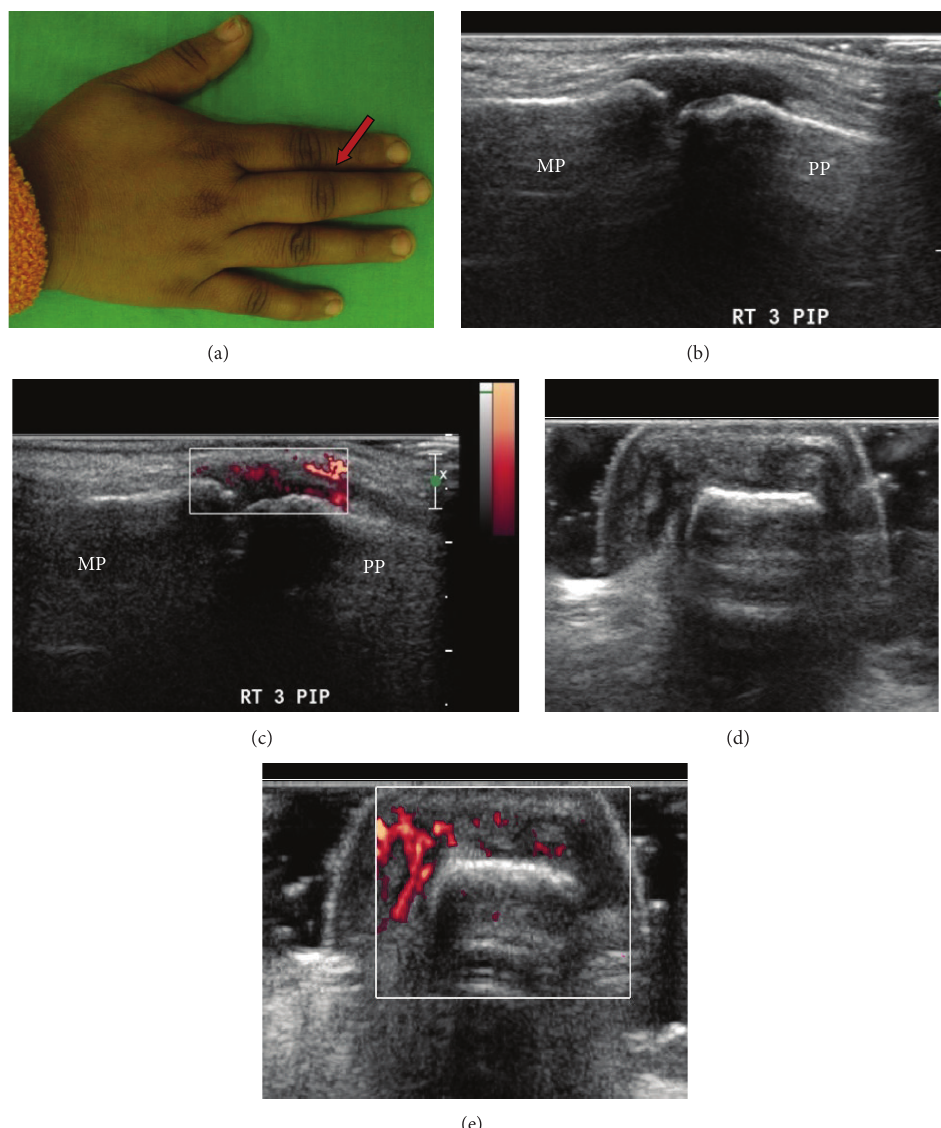
Figure 4: A 30-year-old female patient diagnosed as PsA presented with history of pain and swelling of right third PIP (arrow) (a). DAS28 score was 4.48 (suggestive of moderate disease activity). Ultrasound examination revealed Grade 2 synovial hypertrophy in right third PIP joint (b and d). PD evaluation showed increased signal (Grade 3) within the hypertrophied synovium in the joint (c and e). US scores derived were as follows: GSJC-11, GSJS-18, PDJC-3, and PDJS-7. Longitudinal view (b and c). Transverse view (d and